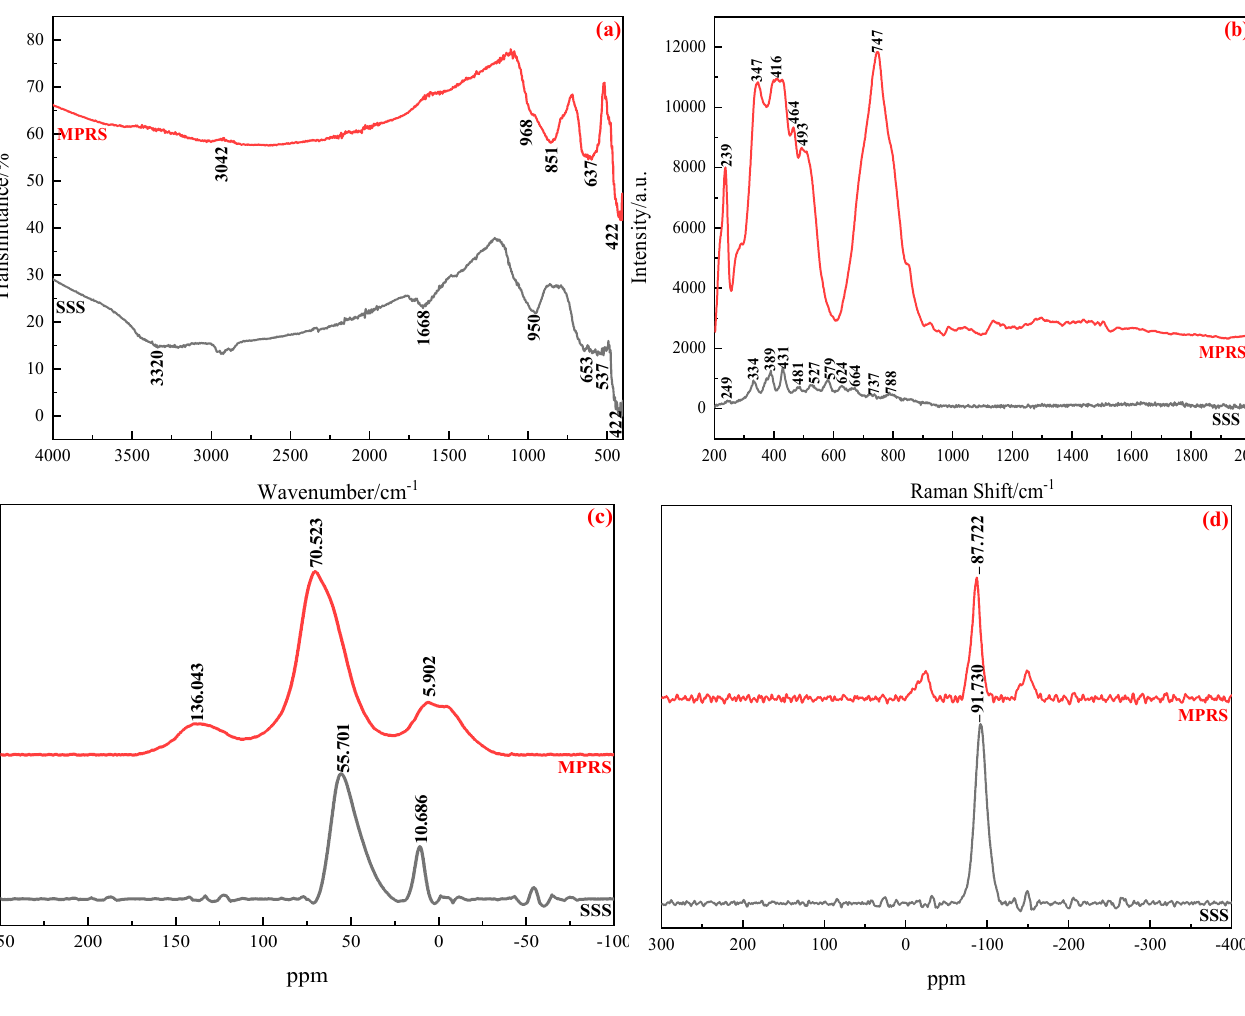
Figure 6. Spectral analysis in the SSS and MPR slags (( a ): FTIR, ( b ): Raman, ( c ): NMR pattern of 27 Al, ( d ): NMR pattern of 29 Si). ( d ): NMR pattern of 29